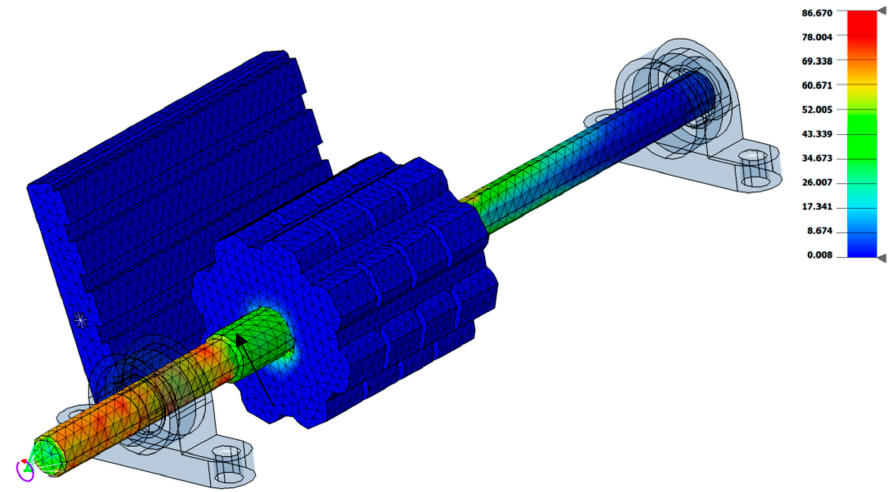
Figure 21. Stress magnitudes (MPa) produced on the mechanism during a blocking condition.